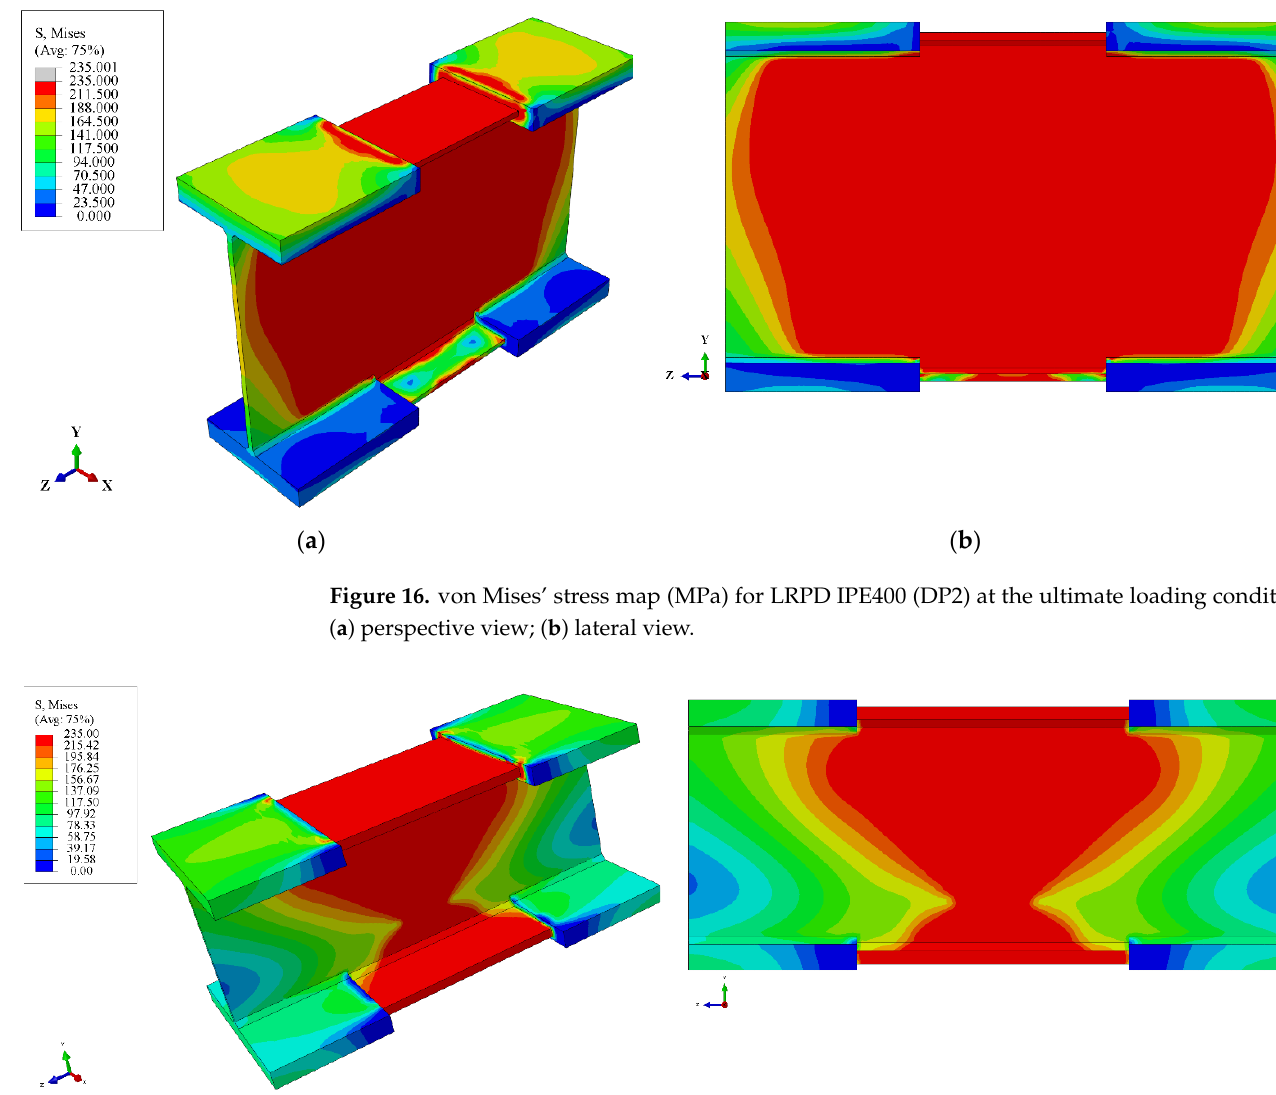
Figure 17. von Mises’ stress map (MPa) for LRPD HEA300 (DP1) at the ultimate loading condition: ( a ) perspective view; ( b ) lateral view.